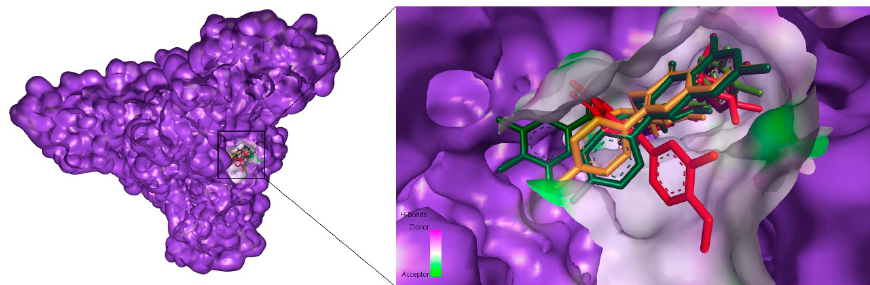
Figure 3. Top scoring ligands (stick model) showing interactions with the receptor binding site of human serum albumin (space filling model). Appl. Sci. 2020 , 10 , x FOR PEER REVIEW Table 3. The ligands from kiwifruit showing interaction with HSA represented with binding energy (BE), dock score (DS), van der Waals (VDW) and H-bond (HB) energy.